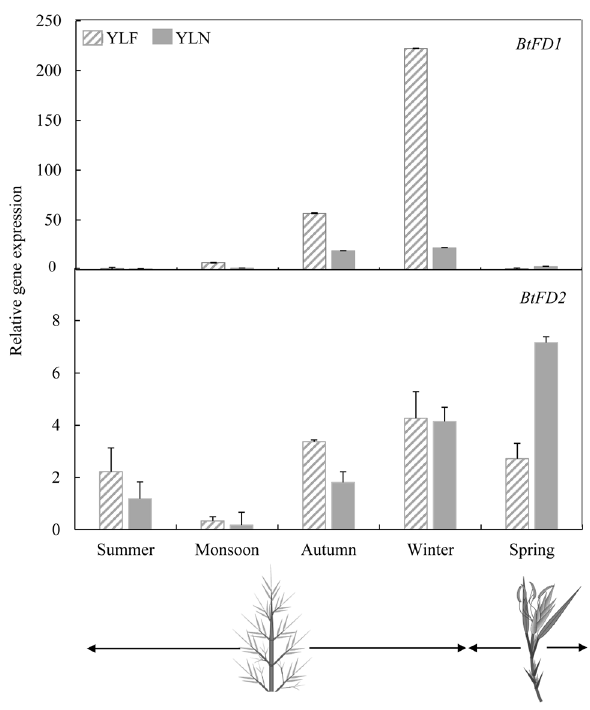
Figure 3. Expression analyses of BtFD1 and BtFD2 genes in YLF and YLN of B. tulda in five different seasons. Each bar represents mean expression of three biological replicates ± SE. The eIF4α was used to normalize expression data of the targeted flowering genes. The relative fold change was calculated by 2 −ΔΔCT method using the expression level observed in rhizome as the calibrator. YLF young leaf from flowering culm, YLN young leaf from non-flowering culm.